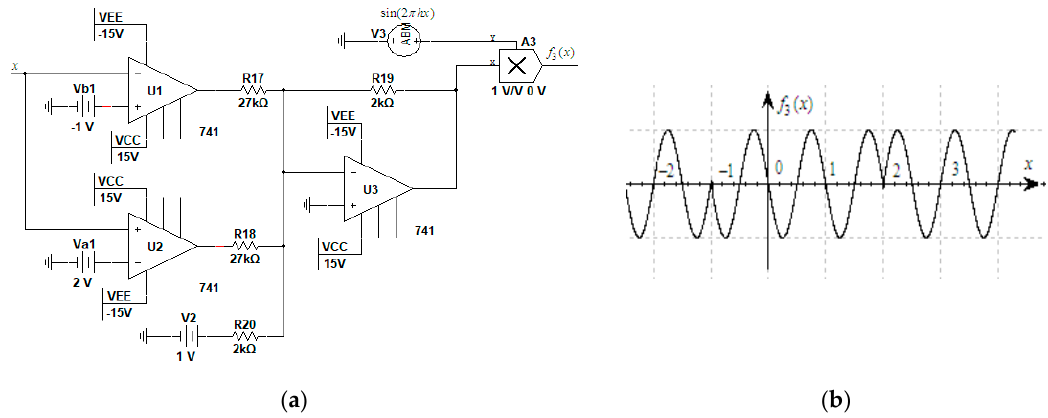
( ) f x : ( a ) electronic circuit with 1 p = , 3